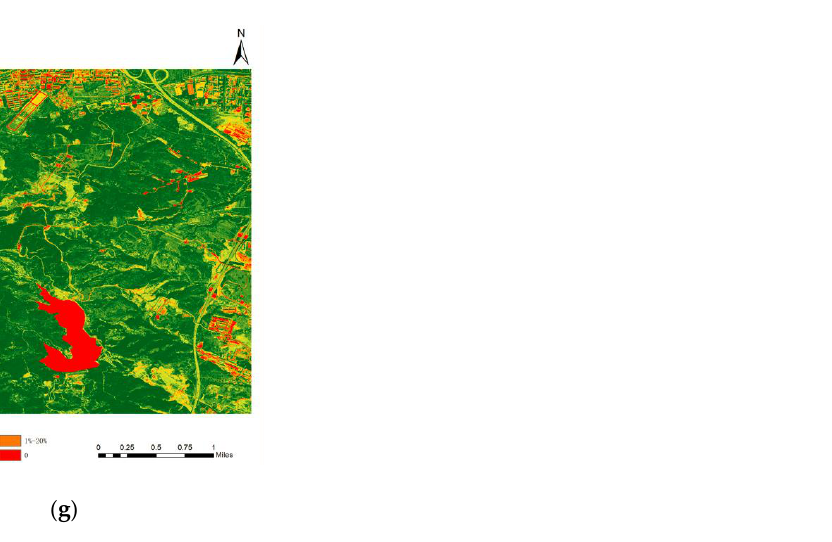
Figure 5. Extraction results of vegetation coverage for different models. ( a ) EXG; ( b ) GRVI; ( c ) EXGR; ( d ) NGBDI; ( e ) RGBVI; ( f ) VDVI; ( g ) CIVE.